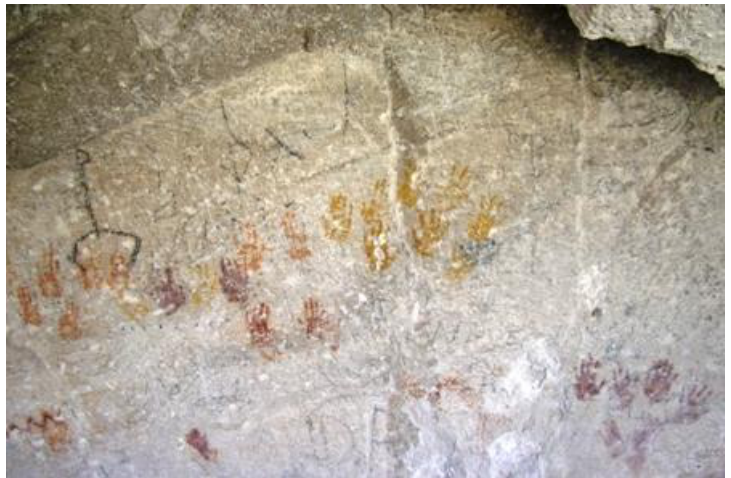
Figure 5. Positive prints, 100 Hands site, Utah, USA.